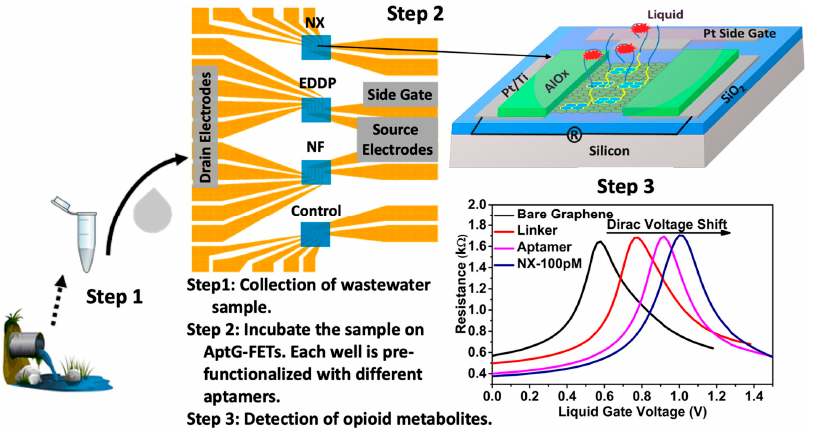
Figure 9. Schematic illustration of an on-site chip-based rapid detection platform for near real-time monitoring of opioid metabolites in wastewater using AptG-FET sensor technology [61]. Reused and adapted with permission from the American Chemical Society.